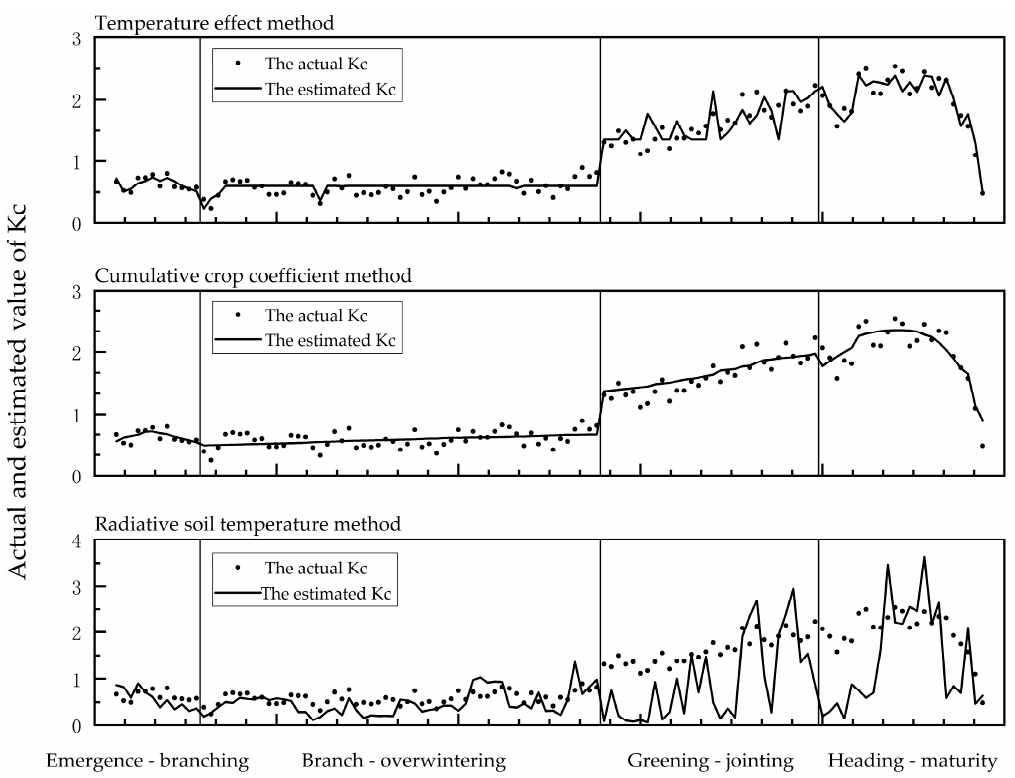
Figure 5. Results of three methods for estimating winter wheat crop coe ffi cients.